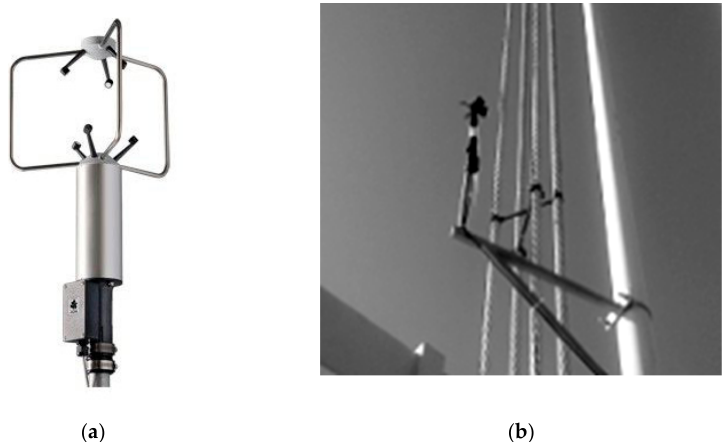
Figure 11. Location of Xihoumen (XHM) Bridge. Figure 11. of Xihoumen (XHM) Bridge.